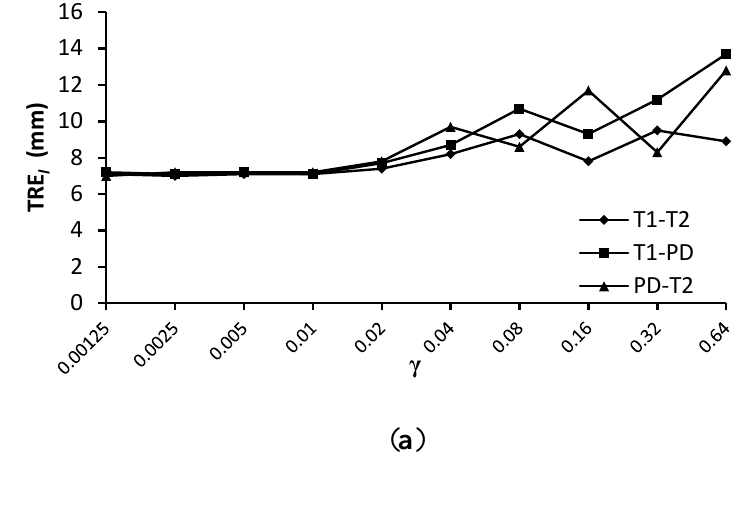
Figure 9. Comparison of registration precision with different for wldWSSIM and wldNSSD. ( a ) wldWSSIM; ( b